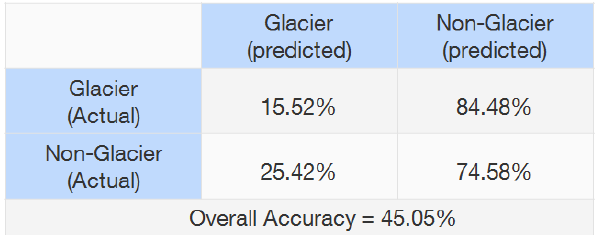
Table 2. Confusion matrix of the classification result only using SAR